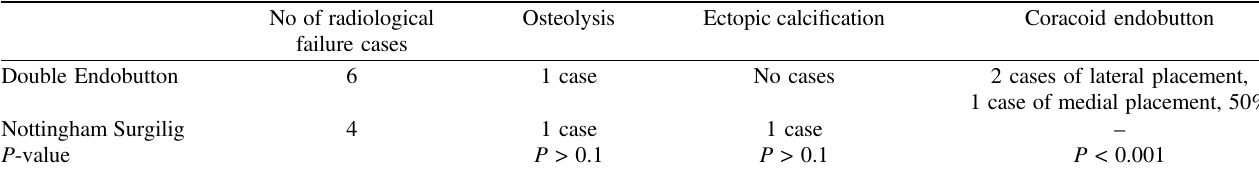
Table 3. Factors assessed during the subsequent evaluation of radiographic failure